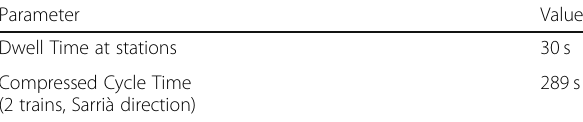
Table 3 Main parameters of the simulated compressed pattern Parameter